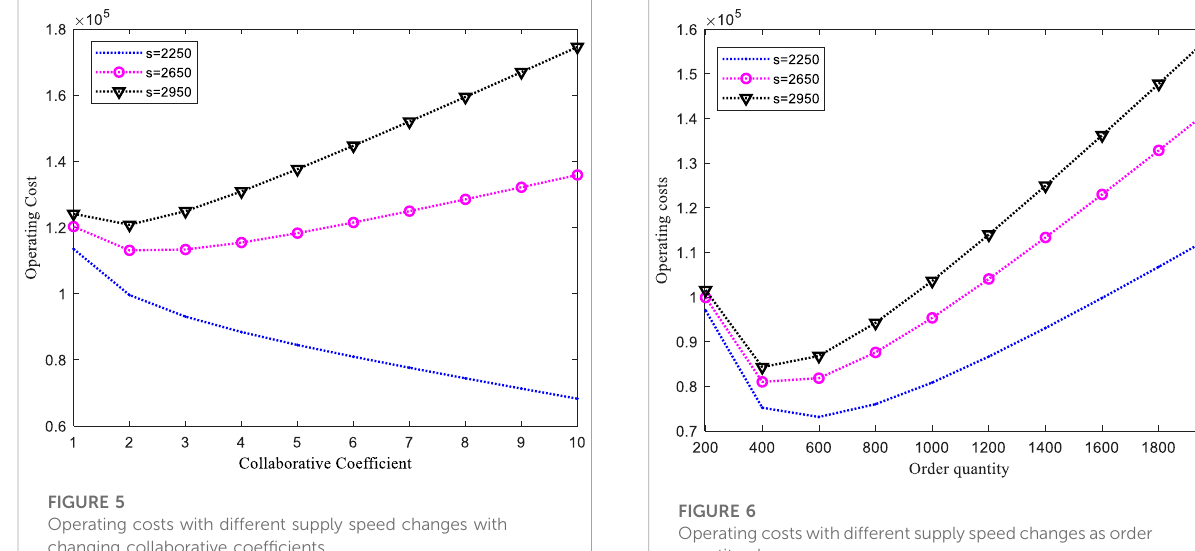
FIGURE 6 Operating costswith differentsupply speedchangesas order quantity changes.